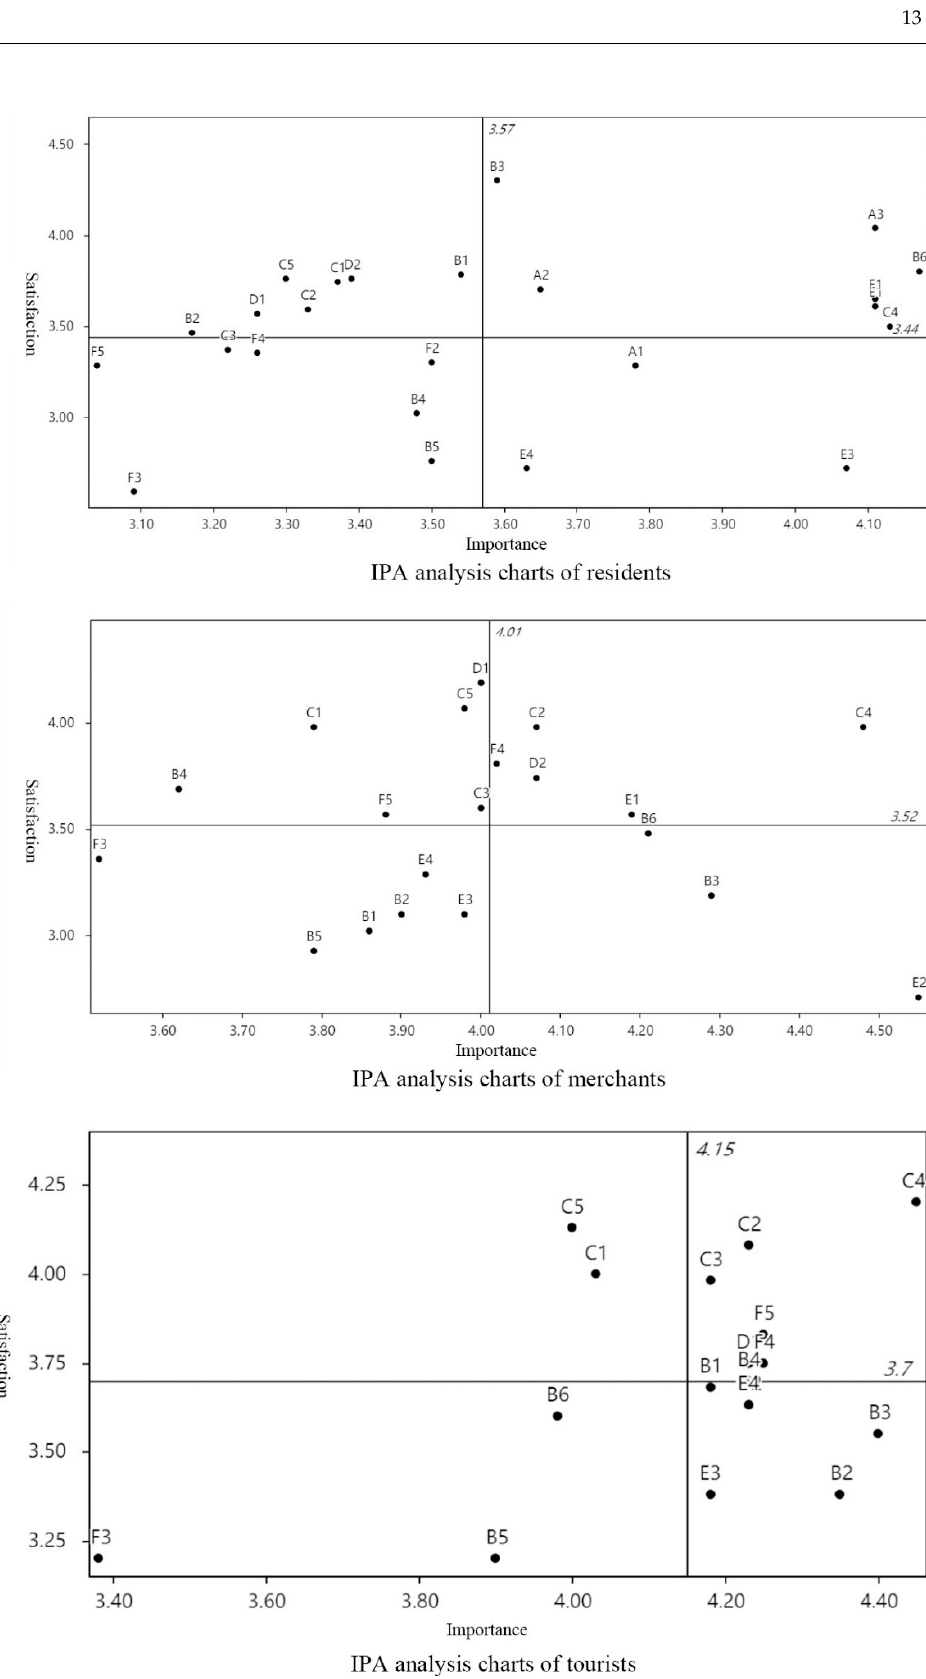
Figure 7. IPA analysis of the multi public.